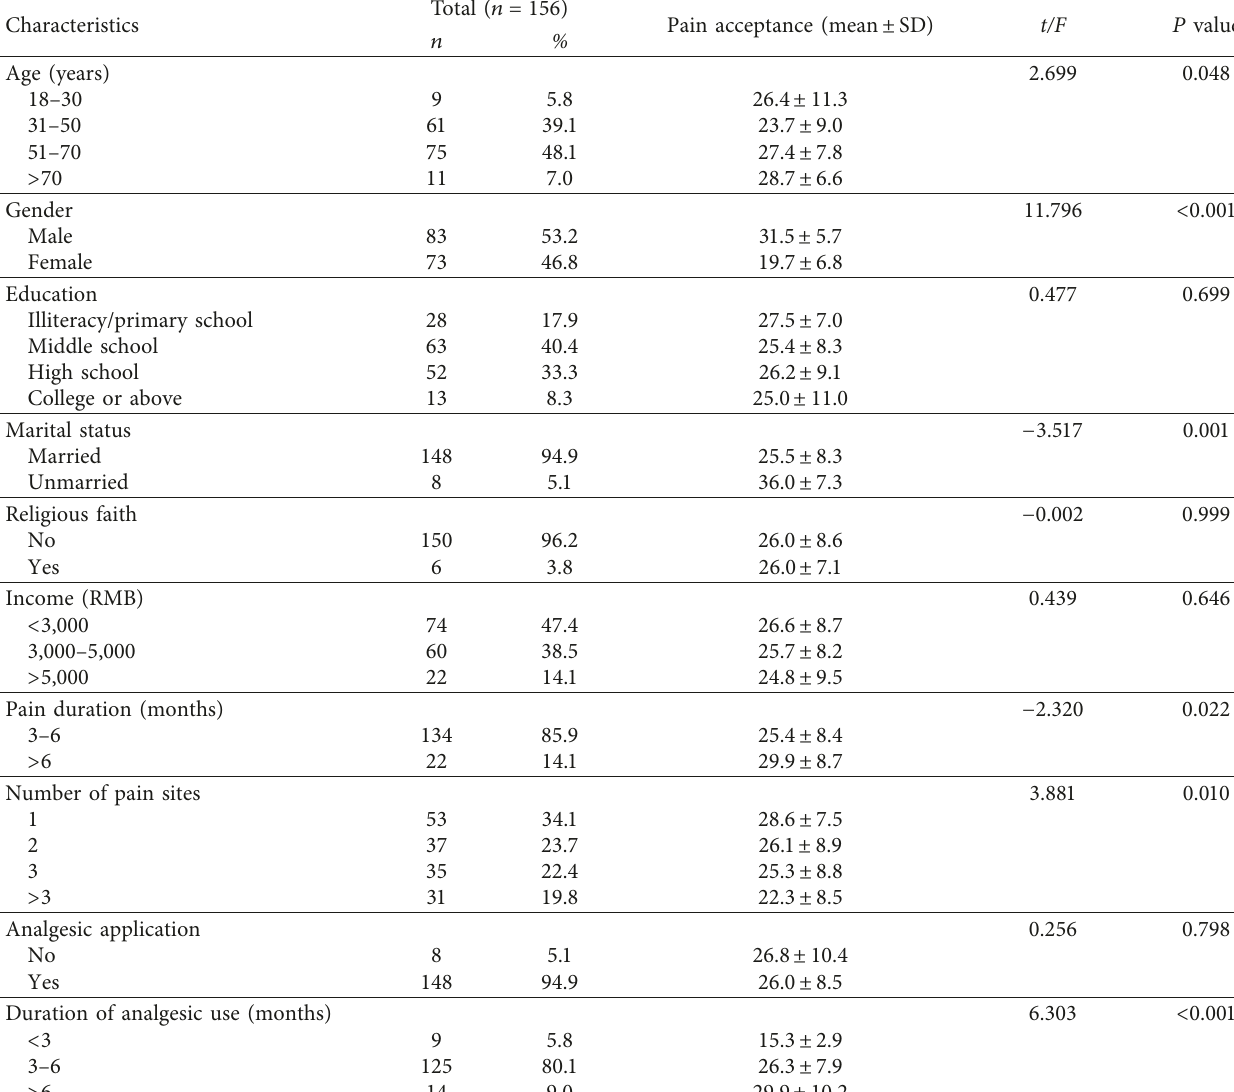
Table 1: Relationships between sample characteristics and pain acceptance.